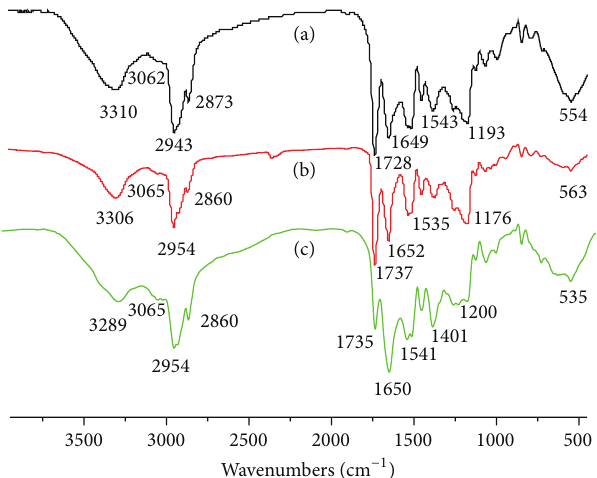
Figure 2: FTIR spectra of PIGB (a), PIGH (b), and PIGA (c).